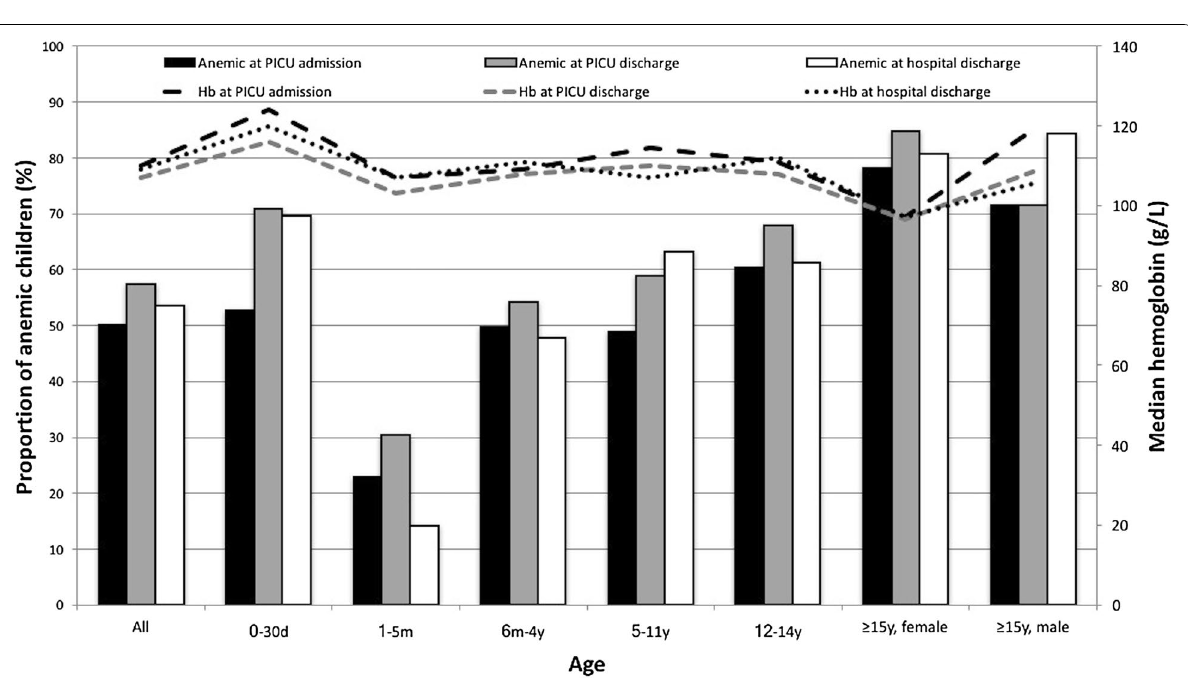
Fig. 3 Double Y -axis graph on the proportion of anemic children at PICU admission, PICU discharge and hospital discharge according to age, and median Hb level at PICU admission, PICU discharge and hospital discharge according to age. Hb hemoglobin, PICU pediatric intensive care